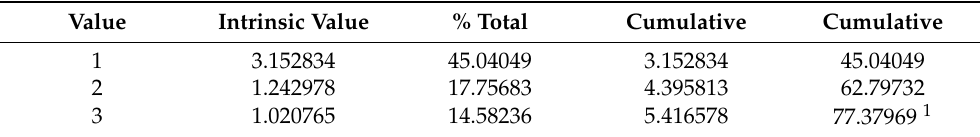
Table 3. Intrinsic